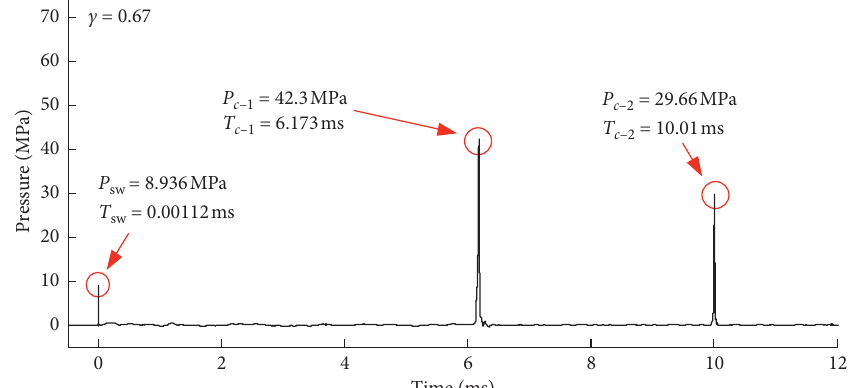
Figure 30: Pressure-time diagram of the first and second cycles of the spark-generated bubble load for c � 0.67.